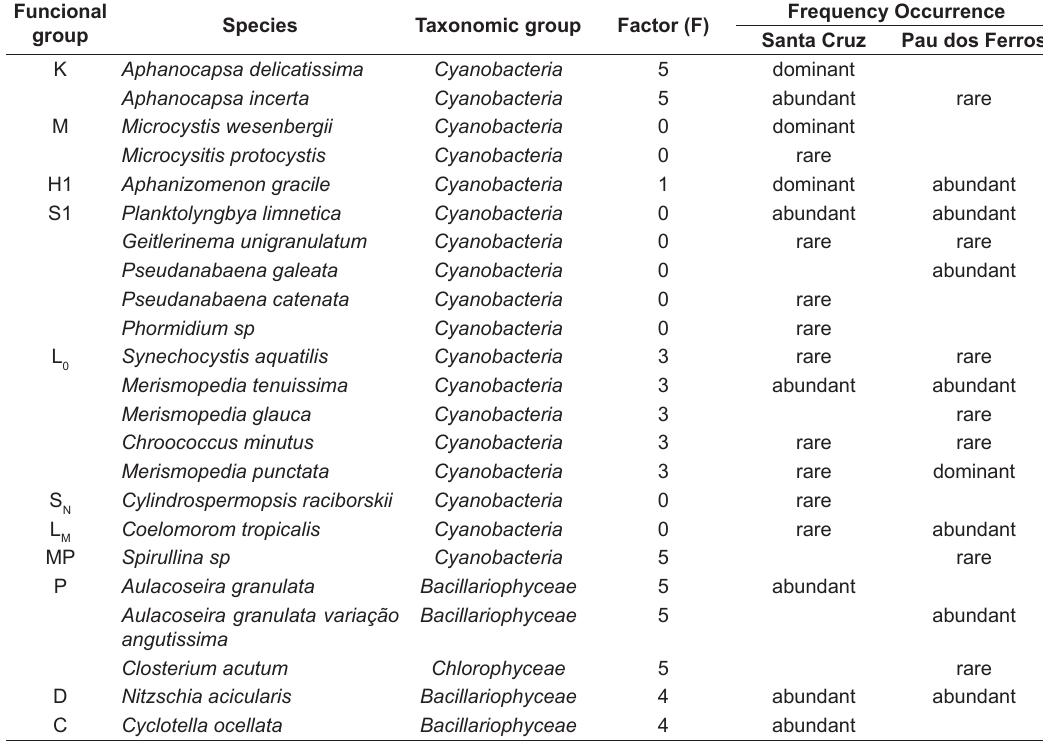
Table 2. Functional groups of phytoplankton (Reynolds et al., 2002), factor (F) used in the calculation of the index Q, frequency of occurrence according to Lobo & Leighton (1986) of the species identified during the study in the Pau dos Ferros and Santa Cruz reservoirs, from October 2011 to May